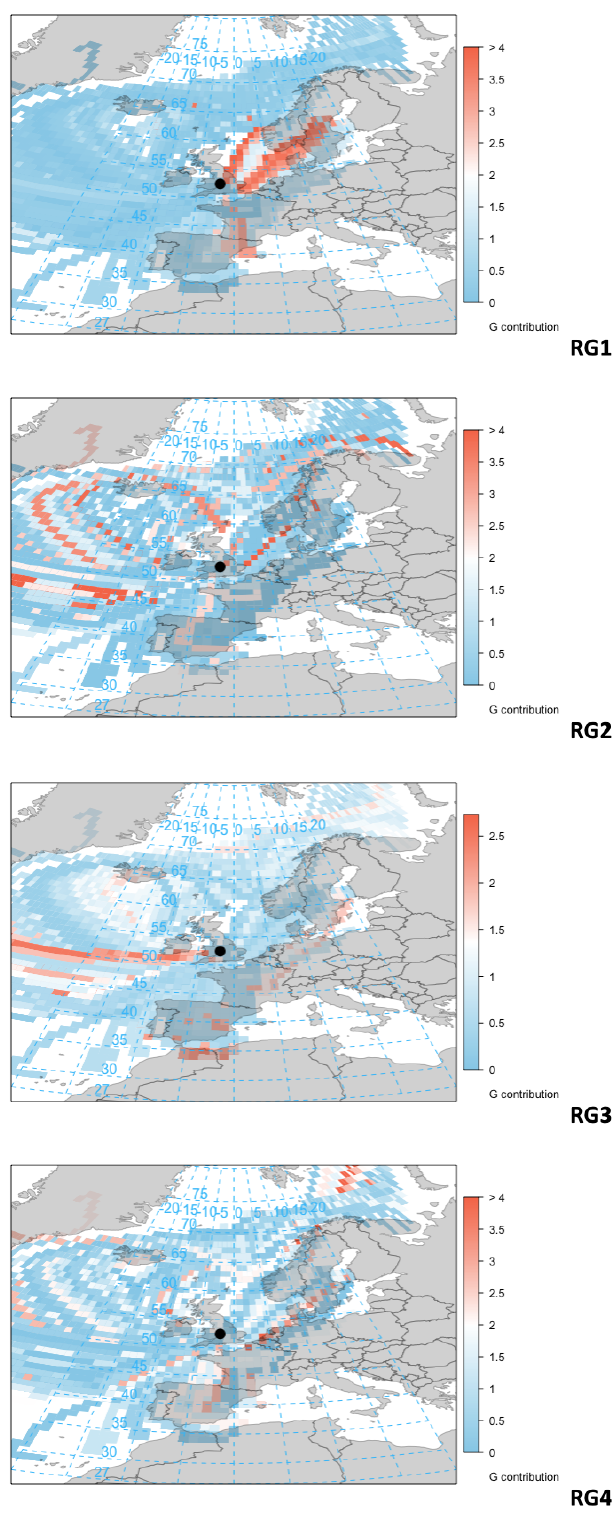
Figure 9. Average G contribution of the factors from the RG ana- lysis for incoming air masses. Higher contributions indicate better association of the given factor with the corresponding air mass ori-